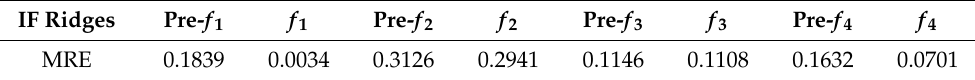
Figure 15. Processing results of the low and resonant frequency band signals of the inner race fault signal using the proposed FMLT: ( a ) FMLT-resulting TFR of the lower frequency band signal, ( b ) FMLT-resulting TFR of the resonant frequency band signal, ( c ) extracted IF ridges from ( a ) using the FPO, and ( d ) extracted IF ridges from ( b ) using the FPO. Table 3. MREs of extracted IF ridges of inner race fault signal.